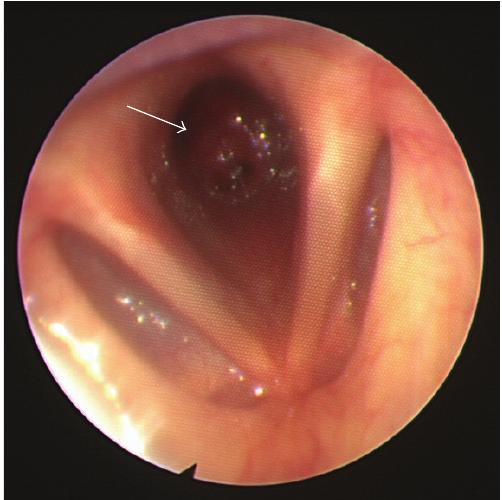
Figure 1: Nasal endoscopy revealed a subglottic mass (arrow) approximately 1cm in diameter causing near-complete obstruction of the